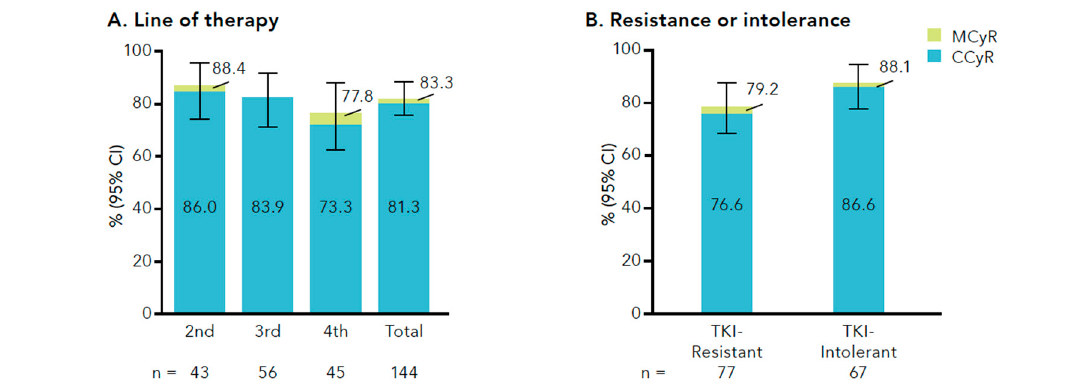
Figure 1. Summary of cumulative incidence of cytogenetic responses in CP CML patients enrolled in the BYOND study by ( A ) line of therapy and ( B ) resistance or intolerance to prior TKIs.